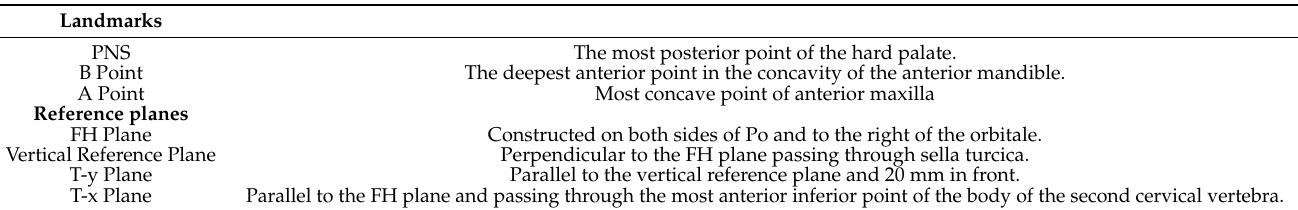
Table 2. The landmarks and reference planes